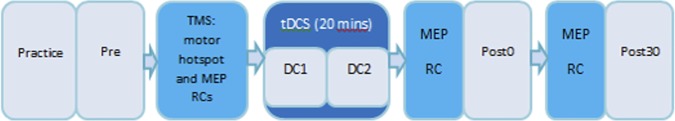
Session schematic.Schematic representation of how the postural control task blocks are separated during each session.